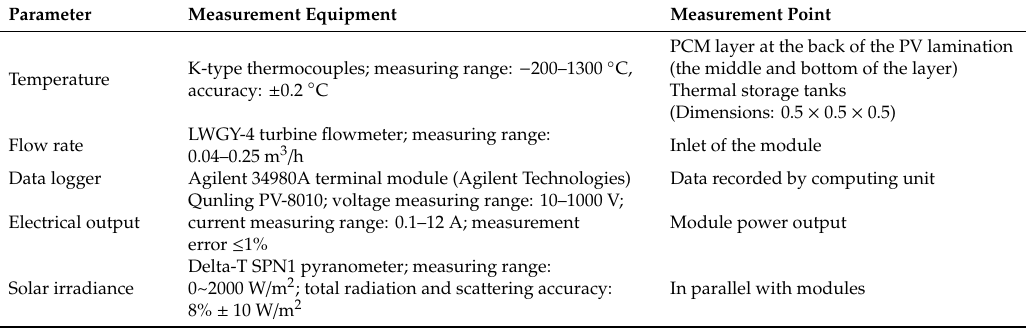
Table 1. Main parameter measurement configuration of the experimental